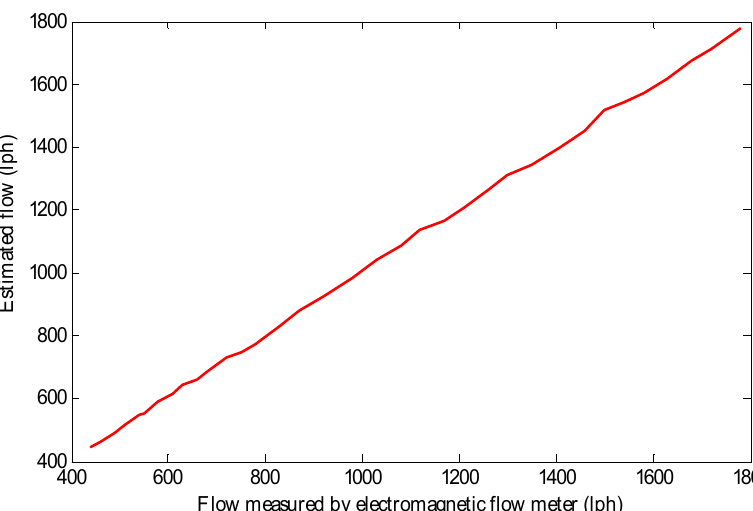
Figure 12. Input-output characteristics of the proposed technique.